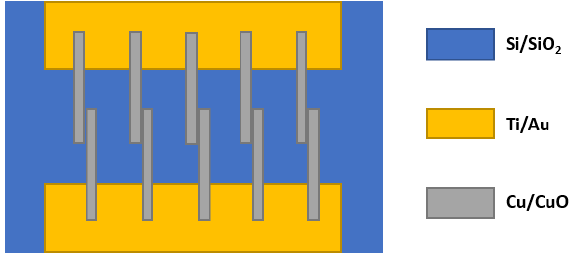
Figure 21. Top view of the fabricated CuO gas sensor.